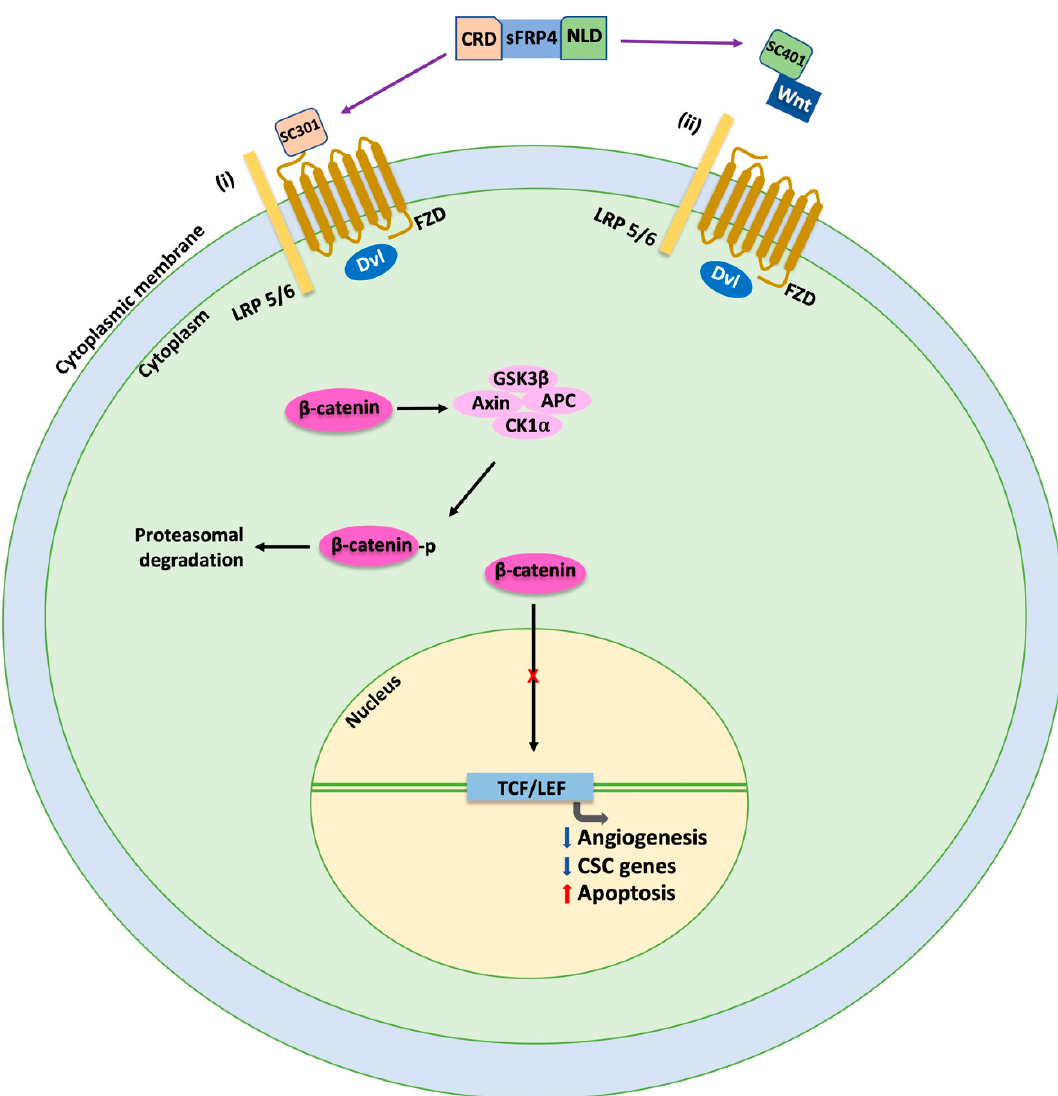
Figure 3. Differential inhibition of Wnt β -catenin-dependent signaling pathway by sFRP4 and its micropeptides. sFRP4 antagonizes Wnt β -catenin-dependent signaling pathway by (i) binding to FZD via its cysteine-rich domain (CRD) and (ii) binding with Wnt via its netrin-like domain (NLD). SC301 derived from CRD domain binds to FZD, whereas SC401 derived from NLD domain binds with Wnt. Inhibition of Wnt signaling leads to phosphorylation of β -catenin and its subsequent pro- teasomal degradation. Lack of β -catenin–TCF/LEF interaction in the nucleus causes suppression of angiogenesis and cancer stem cell (CSC) genes along with activation of apoptosis. CRD, Cysteine- rich domain; CSC, Cancer stem cell; NLD, Netrin-like domain.